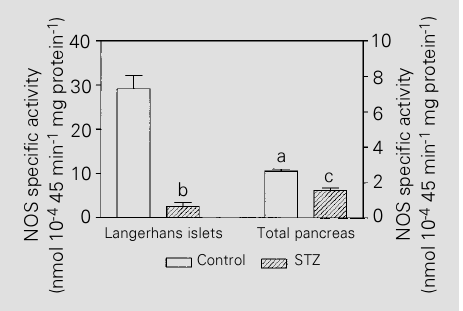
Figure 4 - Specific activity of NOS measured in total pan- creas homogenate and isolated Langerhans islets from control (open bars) and STZ diabetic rats (striped bars). Results are reported as means – SD from three independent experiments and are expressed as nmol 10 -4 of [ 3 H]citrulline formed per mg of protein during 45 min of in- cubation. a) P<0.0068 between Langerhans islet and total pan- creas homogenate activities from control rats, b) P<0.001 between control and STZ Lang- erhans islet activities and c) P<0.02 between control